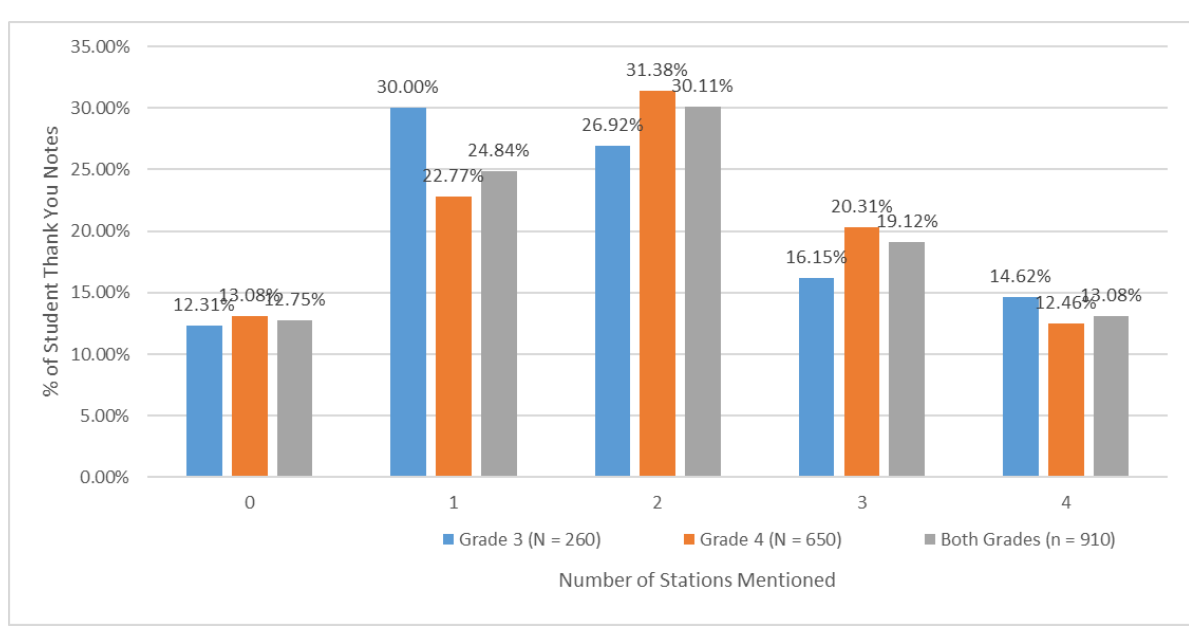
Figure 4. Percentage of Students Remembering Zero to Four Stations by Grade Level